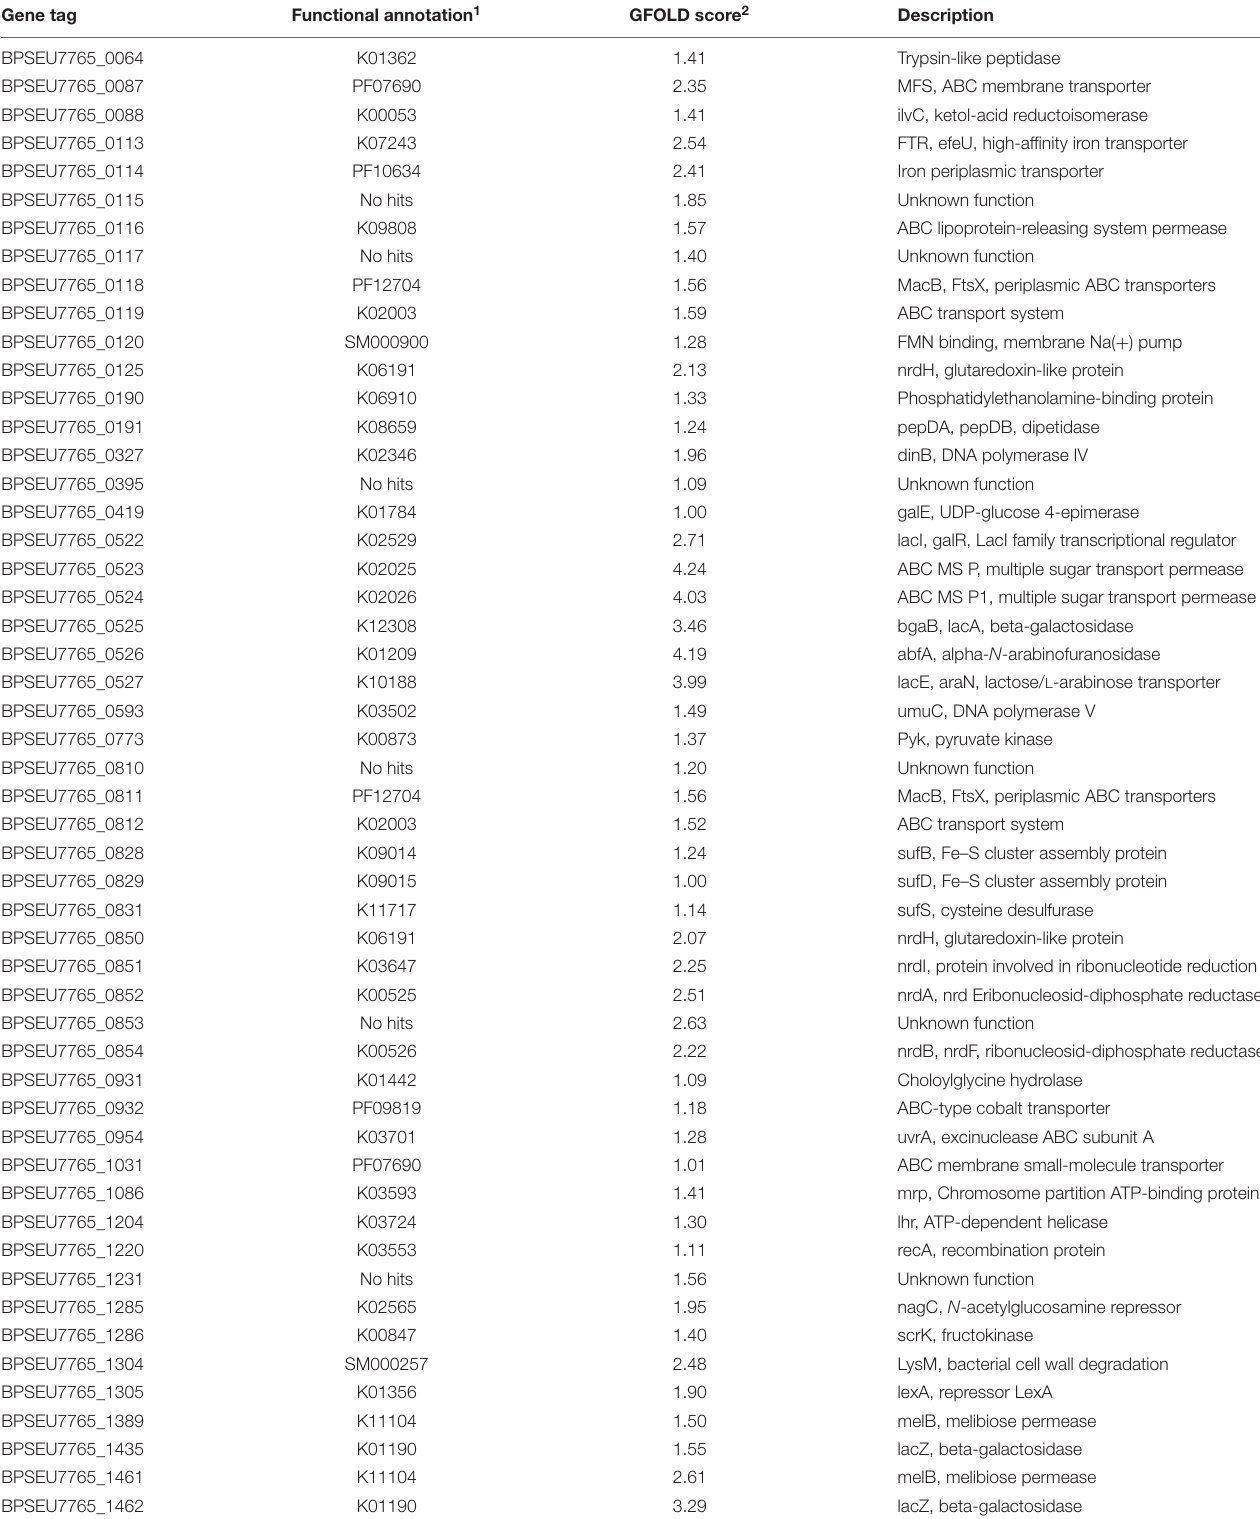
TABLE 2 | List of B. pseudocatenulatum CECT 7765 up-regulated genes during GOS-Lu fermentation. Gene tag Functional annotation